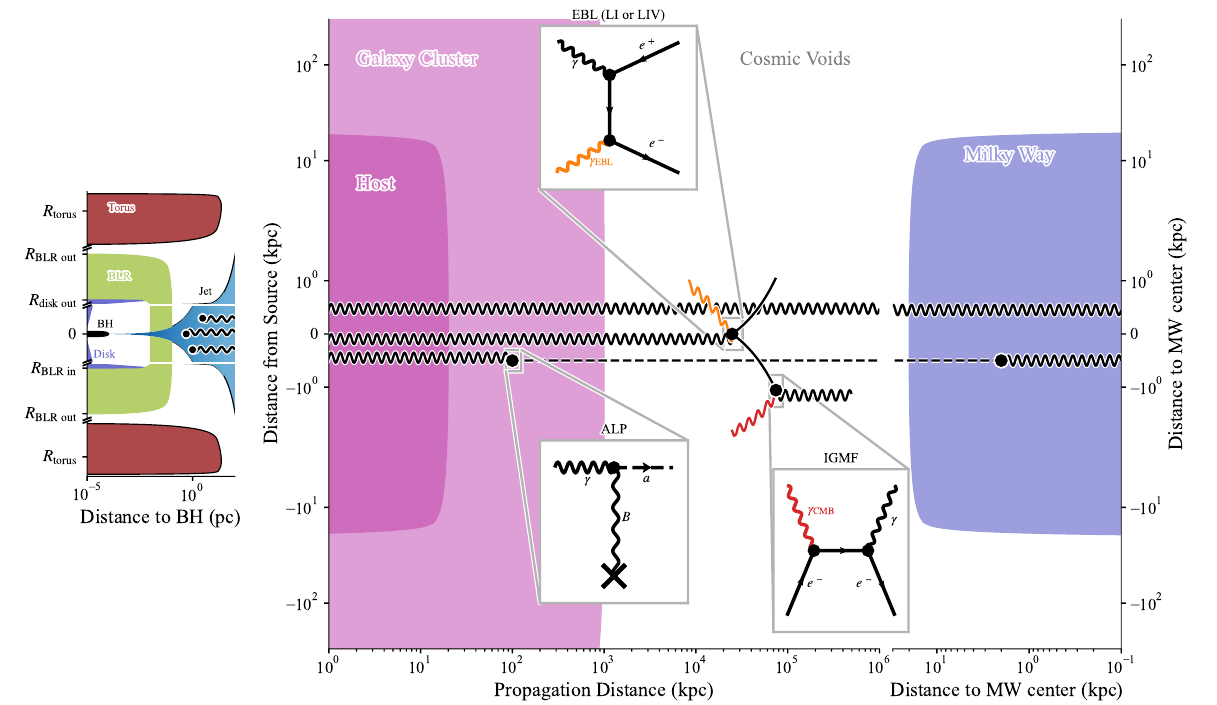
Figure 2. Illustration of gamma-ray propagation from a blazar at luminosity distance d = 1 Gpc ( z ≈ 0.2) to the Milky Way. Left : The inner part of a blazar (here an FSRQ) with a black hole of mass M • = 10 9 M (cid:12) and a radius equal to the Schwarzschild radius 2 r g with r g = GM • / c 2 ≈ 1.5 × 10 14 cm ≈ 4.8 × 10 − 5 pc. The inner and outer radii of the accretion disk, broad line region (BLR), and dusty torus are based on typical values from the literature with R disk, in = 6 r g , R disk, out = 200 r g , R BLR, in = 0.01 pc, R BLR, out = 0.1 pc, R torus, in = 5 pc, R torus, out = 23 pc (e.g., [41]). The jet is assumed to have a parabolic base with a transition into a conical shape at 2 × 10 5 r g (see Equation (13) and Figure 1 in [42]). Not shown here is the possibility of internal absorption of gamma-rays on the photon fields within the source (e.g., on photons originating from the BLR or the dusty torus). Several observations of FSRQs indicate that gamma-rays are produced outside the BLR (see, e.g., [43,44] and references therein). Center : Once produced, the gamma-rays propagate through the host galaxy ( r host = 20 kpc [45]) and potentially through a Galaxy cluster (with r cluster = 1 Mpc here) before entering cosmic voids. The upper gamma-ray propagates all the way towards the observer whereas the central gamma-ray interacts with an EBL photon to form an electron-positron pair at a distance equal to the mean free path, Γ γγ ≈ 250 Mpc, of a 1 TeV gamma-ray. The electron and positron gyrate in the IGMF with r gyro ≈ 540 kpc ( γ /10 6 )( B /10 − 15 G ) − 1 and inverse-Compton scatter off CMB photons after a mean free path of Γ e γ ≈ 730 kpc ( γ /10 6 ) − 1 . The lower gamma-ray converts into an ALP in the magnetic field of the galaxy cluster. Right : The surviving gamma-ray enters the Milky Way and the ALP converts back to a gamma-ray in the magnetic field of our